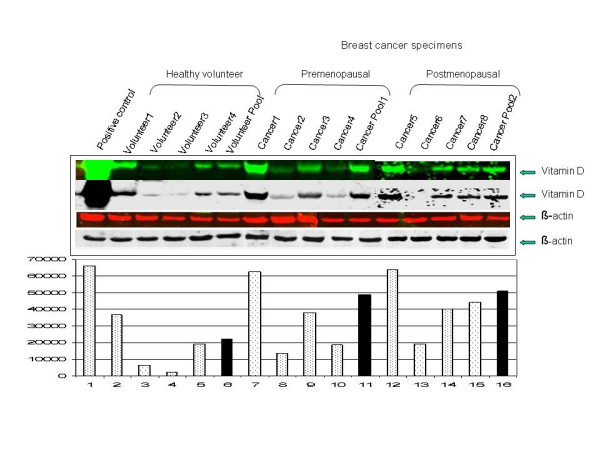
Western blot analysis of independent NAF sample set. The relative difference in vitamin D-binding protein expression in the pooled samples of NAF from healthy volunteers versus NAF from women with early-stage breast cancer was two-fold (P = 0.04; standard error = 9703.7 (solid bars). Individual NAF specimens showed variation in vitamin D-binding protein expression among both healthy volunteers and women with early-stage breast cancer (dotted bars). Menopausal status did not affect expression of vitamin D-binding protein in NAF.